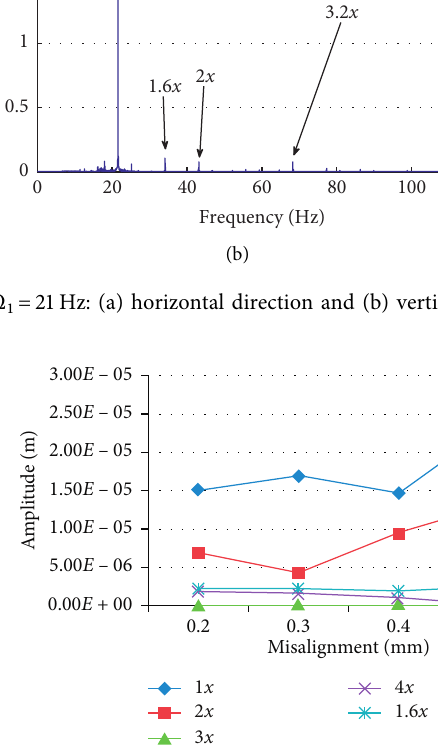
Figure 25: Amplitude of harmonic frequencies altering with misalignment value (test